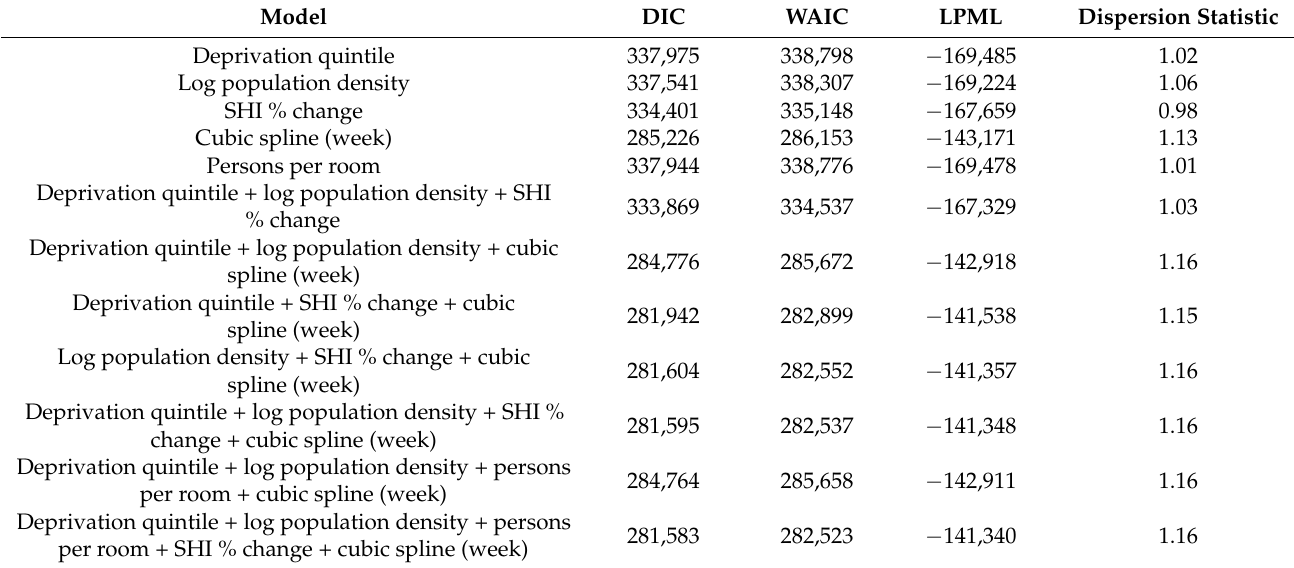
Table 2. Comparison of spatio-temporal negative binomial BYM